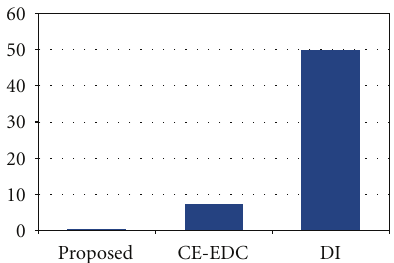
Figure 22: Comparison of computation times for reaction calcula-